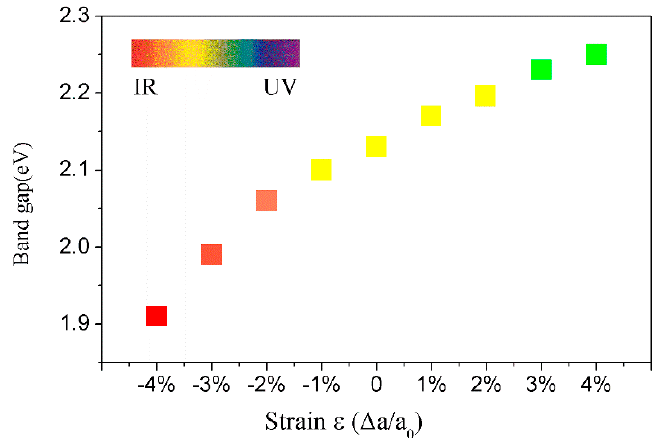
Figure 5. Case of band-gap changes as the tensile force changes. The color of the squares in figure represents the color of the solar spectrum that should be absorbed.